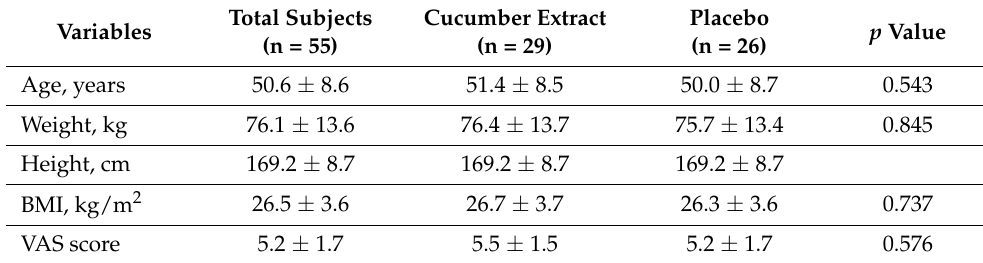
Table 2. Characteristics of participants at baseline.